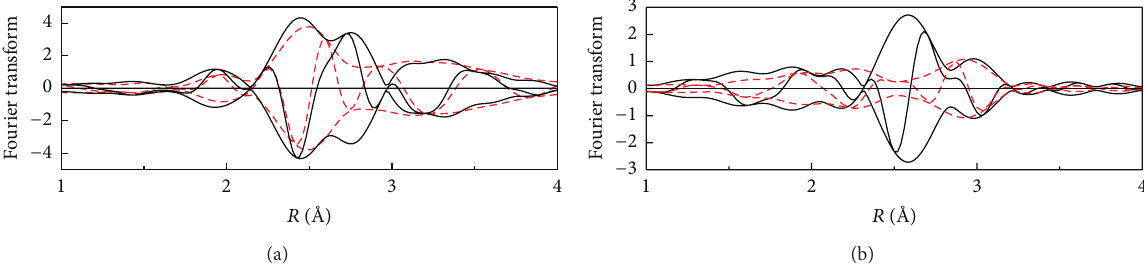
Figure 3: Illustration of (a) Pt-Ru contribution for Pt-Ru black : imaginary part and magnitude of Fourier transform ( 𝑘 2 -weighted, 3.0 < 𝑘 < 16 ˚A −1 , Pt-Pt phase and amplitude corrected) for raw data at Pt L III edge minus calculated Pt-Pt (red line) and raw data (black line) and (b) −1 Ru-Pt contribution for Pt-Ru black : imaginary part and magnitude of Fourier transform ( 𝑘 2 -weighted, 3.0 < 𝑘 < 16 ˚A , Ru-Ru phase and amplitude corrected) for raw data at Ru K edge minus calculated Ru-Ru (red line) and raw data (black